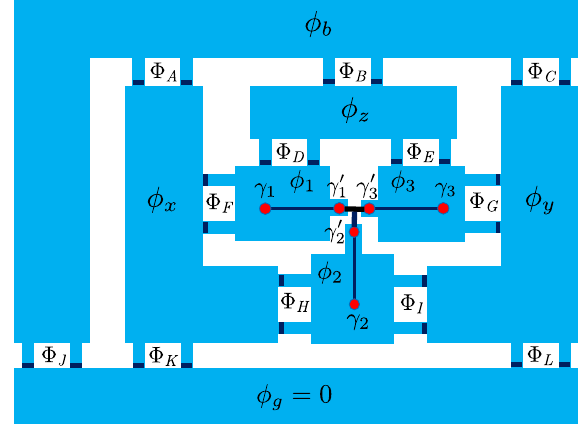
FIG. 17. T -junction architecture with parity-check ability. Every MZM island can be connected to the bus (ground) with the other two MZM islands connected to the ground (bus). No MZM islands share a split Josephson junction; thus, the Coulomb couplings for different MZM pairs are independent of each